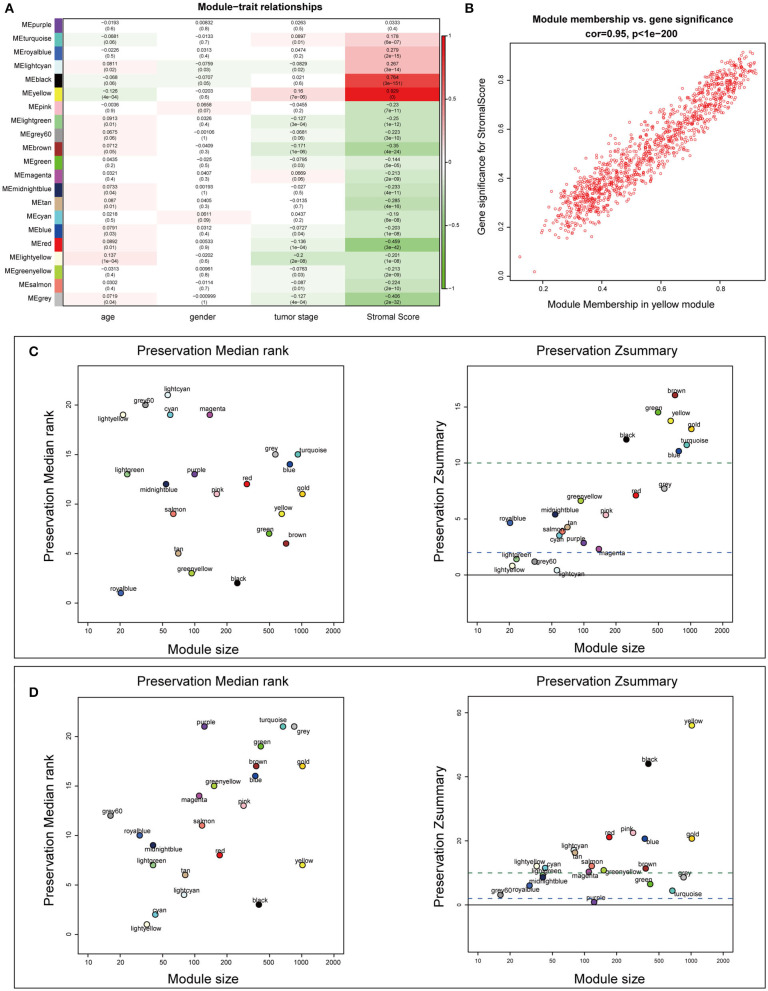
Identification of stroma-relevant mRNA modules and module preservation analysis. (A) Heatmap of module-trait relationships. (B) Scatter plot of correlations between gene module membership and gene significance in the yellow module. (C,D) Preservation medianRank and Zsummary graphs of the testing sets dataset100 and dataset428. Dashed blue and green lines show the thresholds Z = 2 and Z = 10, respectively.